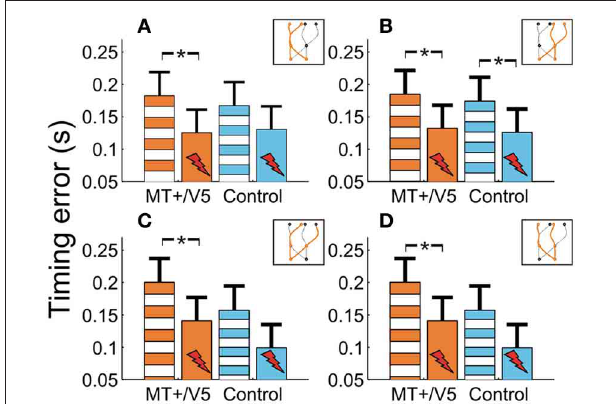
FIGURE 7 | The temporal interception errors for MT + /V5 and its control site as a function of target position at movement initiation (A and B) and as a function of target position at interception (C and D). Asterisks indicate significant differences.